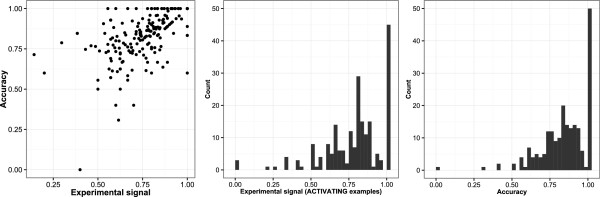
ACTIVATING feature profiles. Left, accuracy vs experimental signal (full supporting examples) of 210 ACTIVATING features. Middle, experimental signal (ACTIVATING examples only) histogram of the 210 ACTIVATING features. Right, accuracy histogram of the 210 ACTIVATING features.